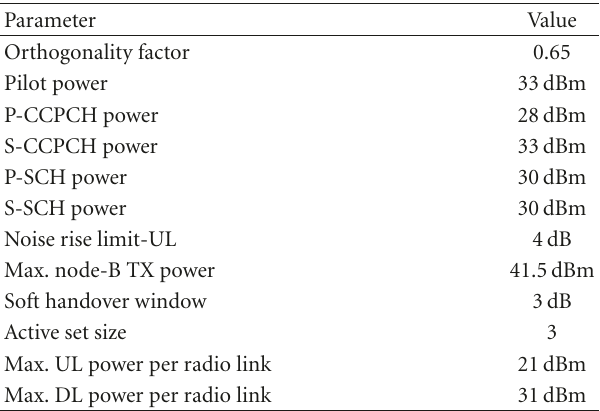
Table 2: System simulation